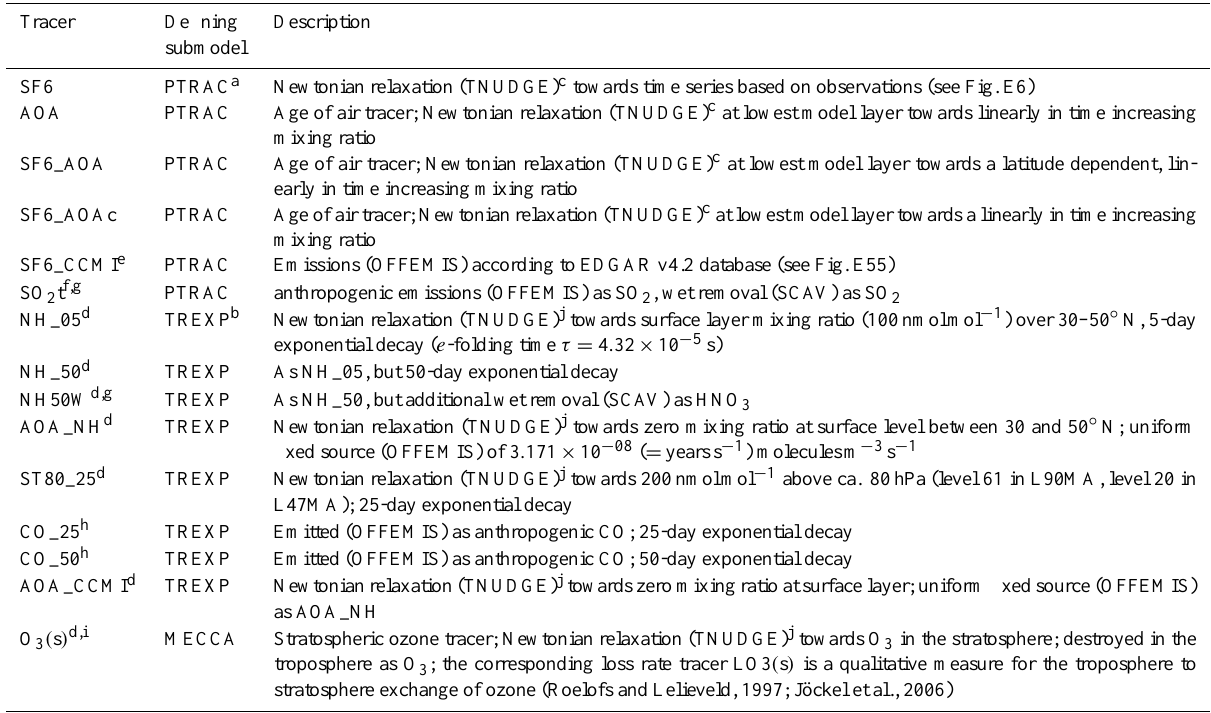
Table A1. Additional diagnostic tracers. Acronyms in parentheses denote the submodels simulating the indicated processes. Corresponding data files are listed in Table